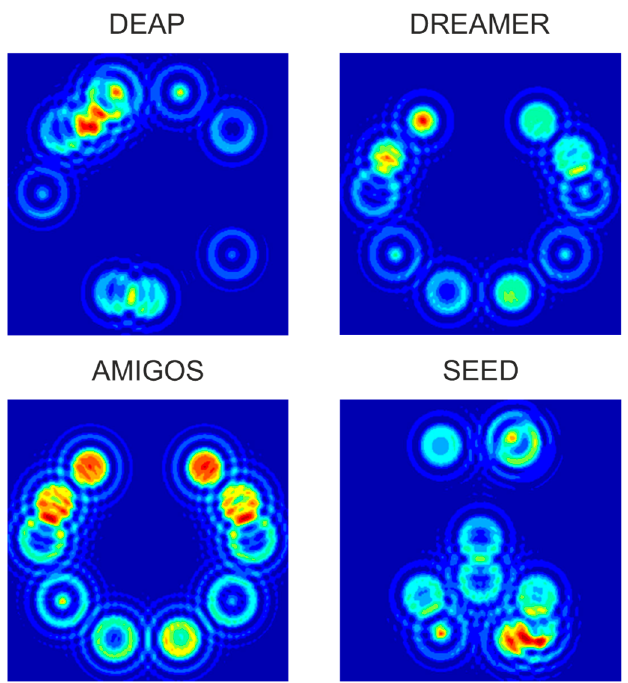
Figure 4. Example of holographic feature maps for each dataset.